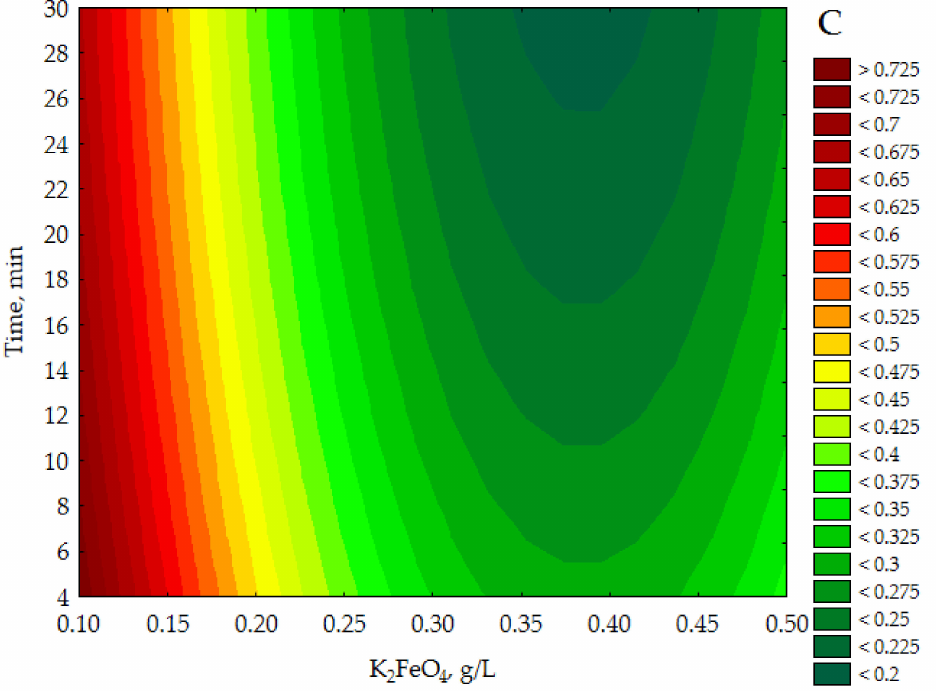
Figure 3. Response surface plots for COD (g O 2 / L) with respect to K 2 FeO 4 (g / L) and pH ( A ), time (min), and pH (g / L) ( B ) and time (min) and K 2 FeO 4 (g / L) ( C